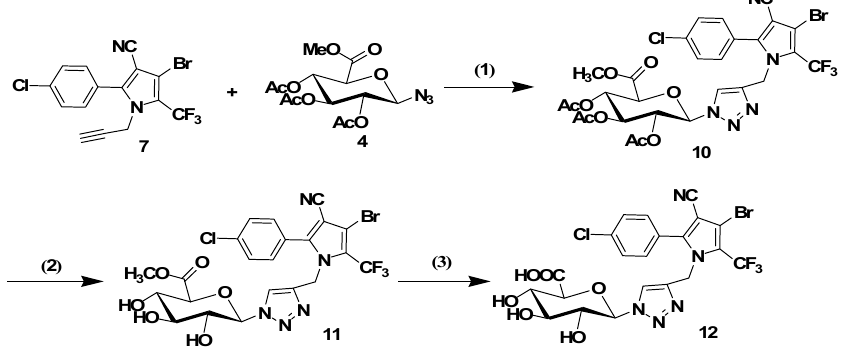
Scheme 3. Synthesis of methyl glucuronate or glucuronic acid conjugate s with a space arm of methene group. Reagents and conditions: (1) CuSO 4 ·5H 2 O (0.4 equiv), sodium ascorbate (0.8 equiv), 1:1 t- BuOH/H 2 O, 60 °C, 3h; (2) 0.05 M NaOMe/MeOH, Room Temperature, 0.5 h, Amberlite IR 120H + ;(3) KOH, MeOH, 0 °C, rt, overnight, Amberlite IR 120H + .